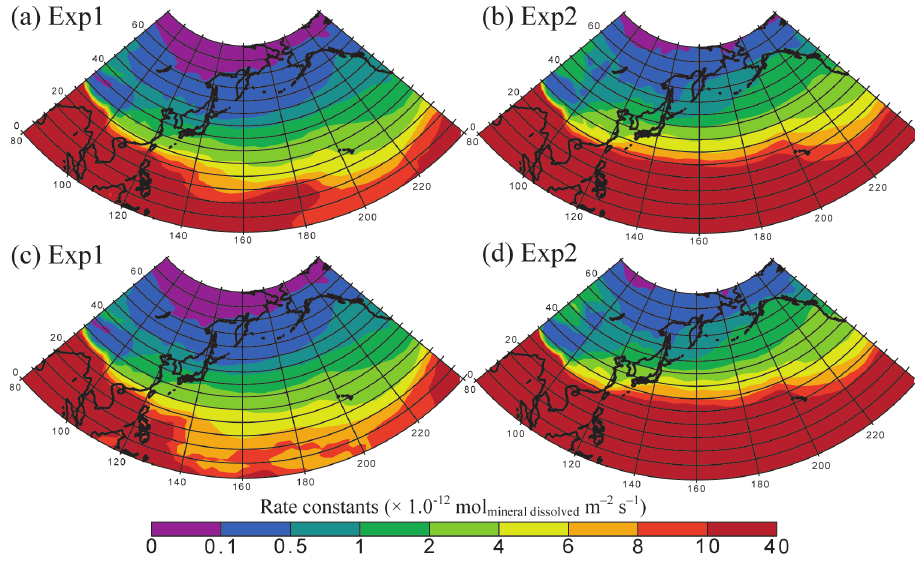
Fig. 6. Modeled dissolution rate constants ( × 1.0 − 12 mol mineral dissolved m − 2 s − 1 ) for hematite (RS3) in the surface air during April 2001 for (a) the fine mode with the alkaline dust, (b) the fine mode without the alkaline dust, (c) the coarse mode with the alkaline dust, and (d) the coarse mode without the alkaline